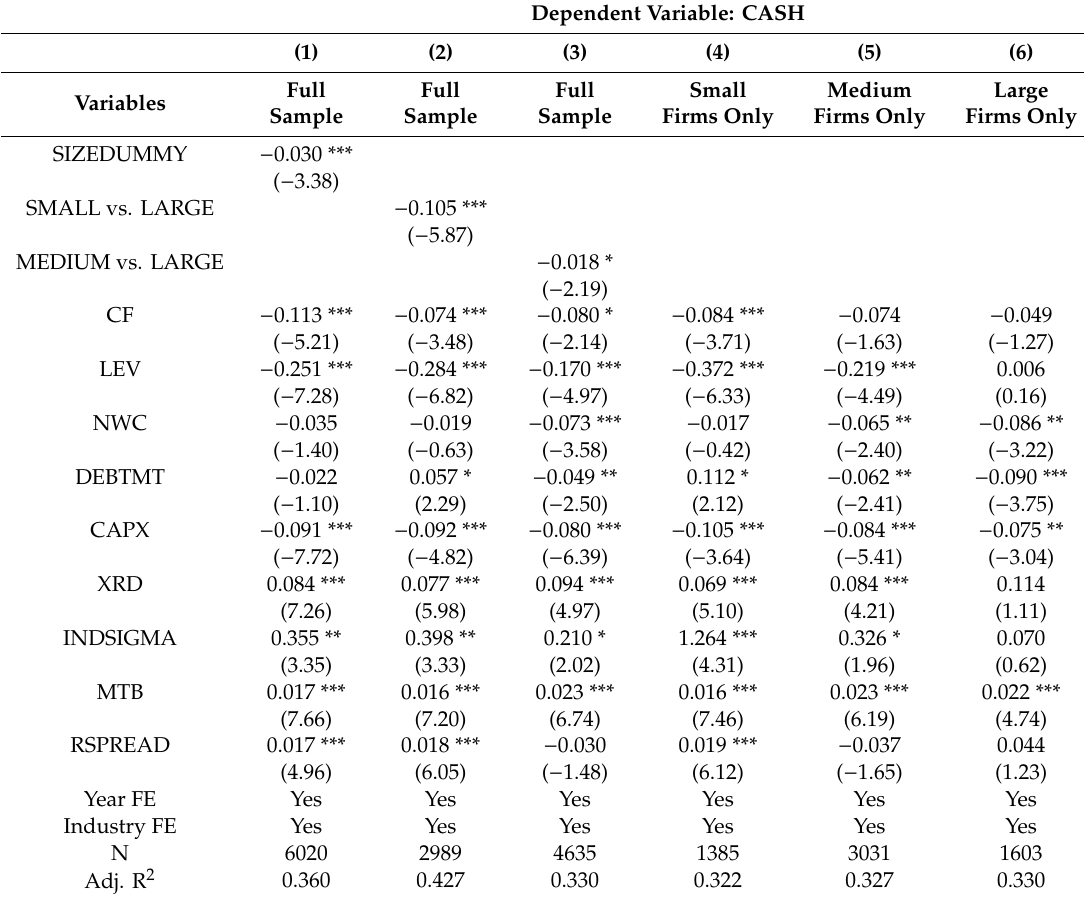
Table 7. Regression results of comparison for small, medium, and large